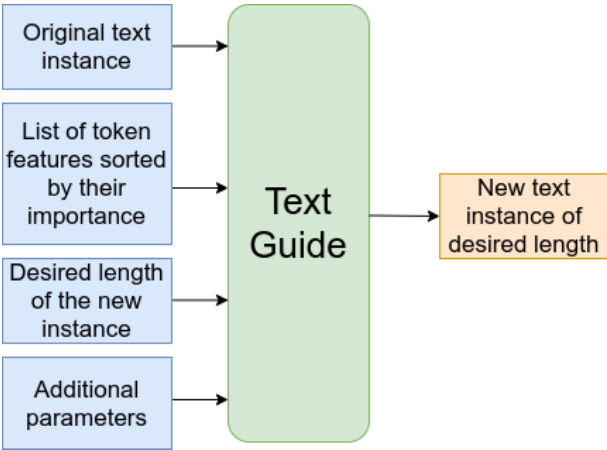
Figure 1. Inputs and output for the Text Guide method.